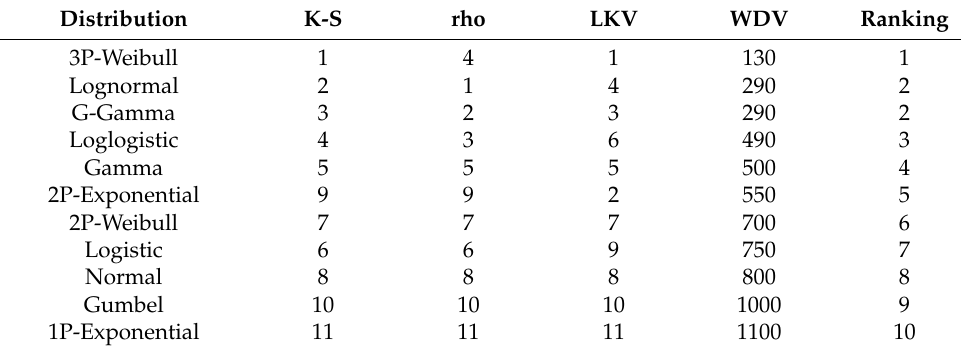
Table 4. Ranks of distributions for hatchback body type.